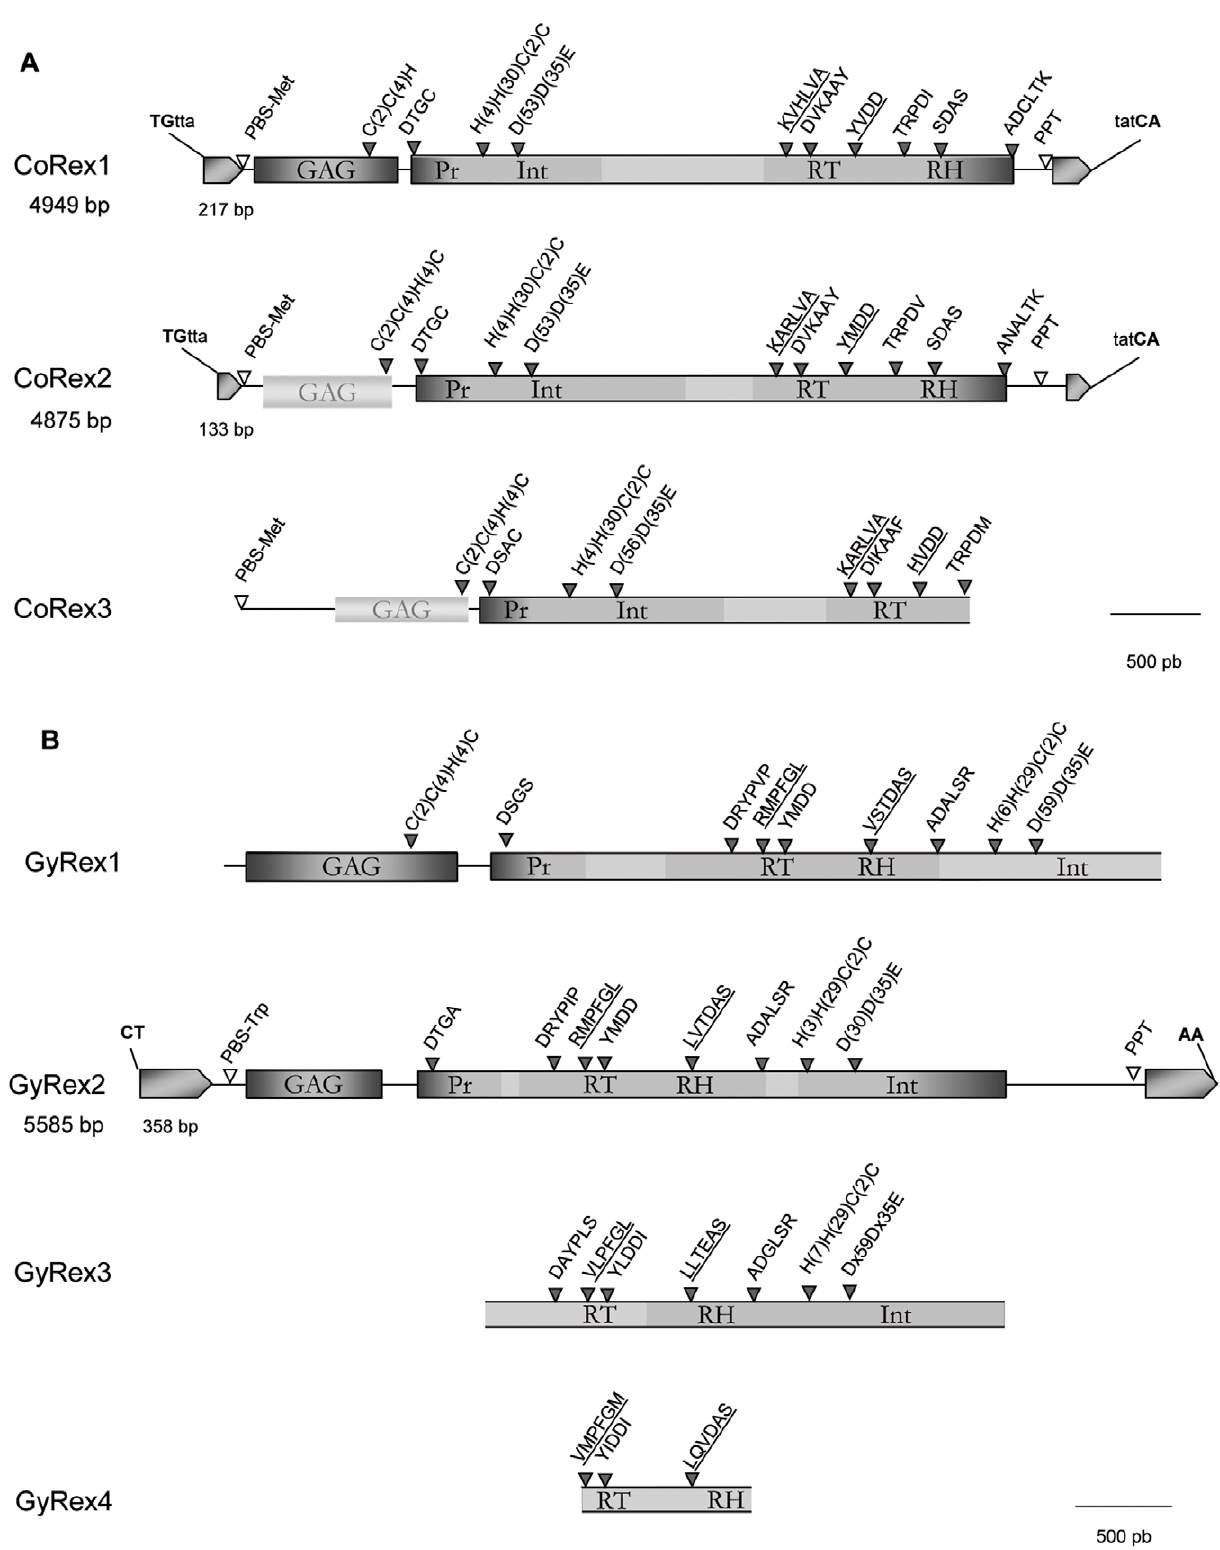
Figure 1. CoRex (A) and GyRex (B) retrotransposons annotation. When an element is described in full-length, its size (in bp), the size of its LTRs and its bordering nucleotides are given. The gag and pol regions are represented using grey blocks and their conserved domains are indicated by black triangles. Light grey blocks show putative altered gag regions. Positions of the Primer Binding Site (PBS) and the PolyPurine Tract (PPT) are indicated by white triangles.